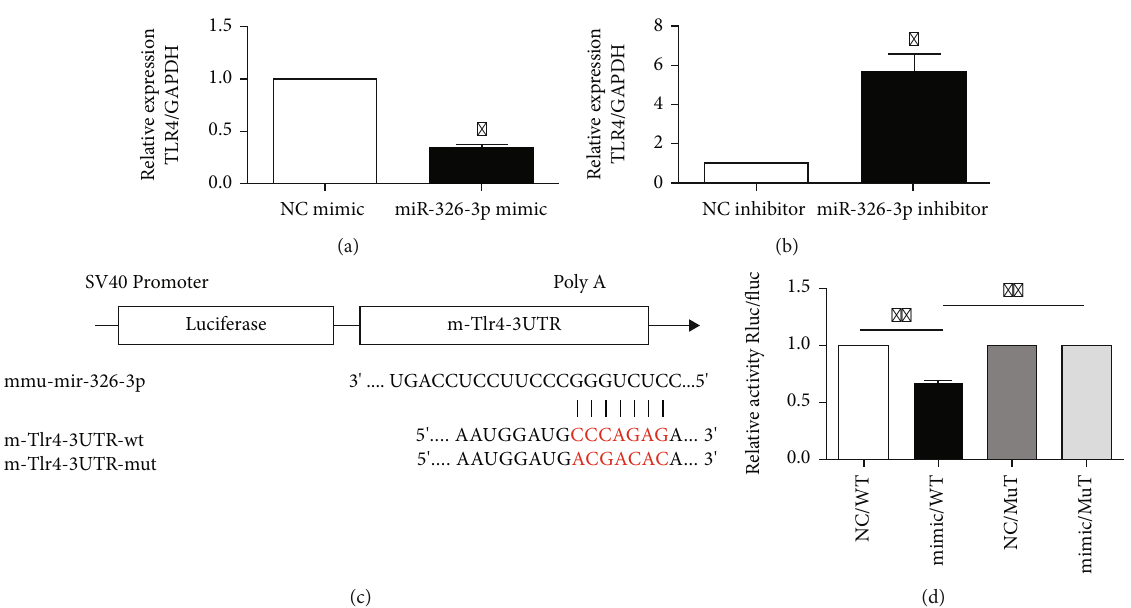
Figure 4: TLR4 as a target gene of miR-326-3p. (a) TLR4 mRNA expression in skin fi broblast cells after transfected with miR-326-3p mimic. (b) TLR4 mRNA expression in skin fi broblast cells after transfected with miR-326-3p inhibitor. (c) Predicted binding sites for miR-326-3p target gene TLR4. (d) Double luciferase assay veri fi ed the targeted association between TLR4 and miR-326-3p. ∗ p < 0 : 05 vs. NC, ∗∗ p < 0 : 01 vs. NC.